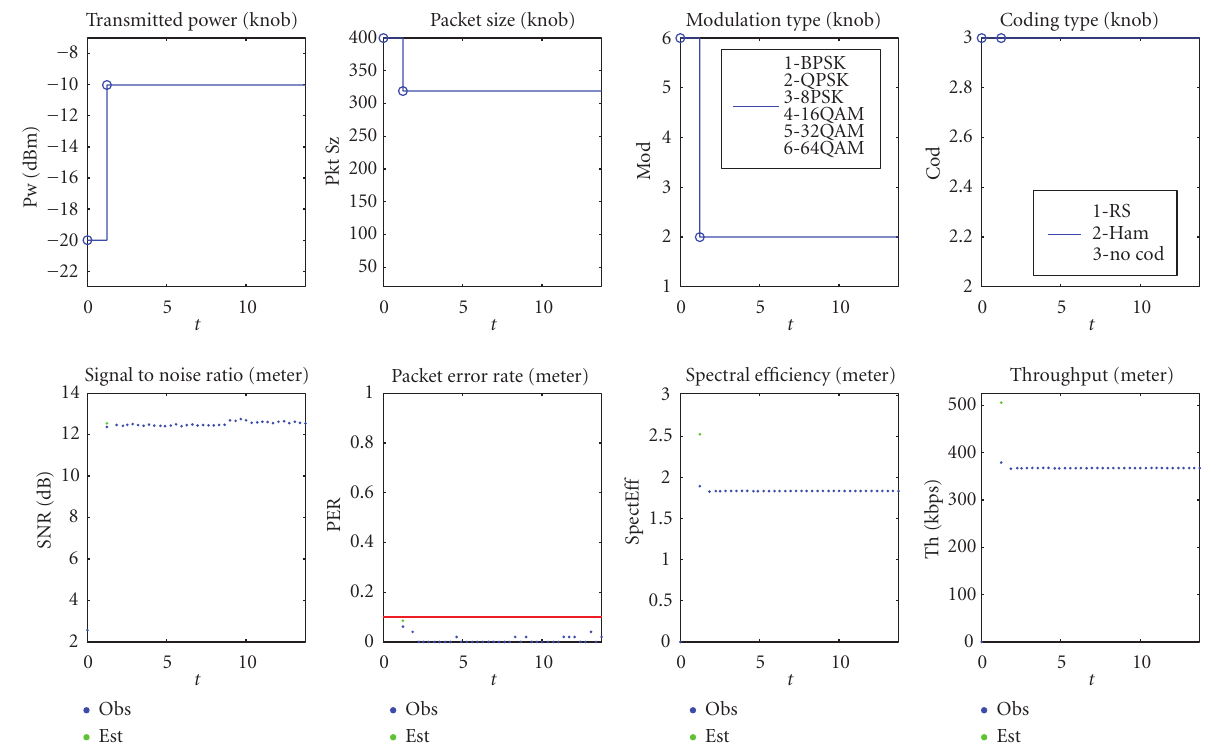
Figure 6: CE with narrow-band interference—in the presence of the narrow-band interference, the engine again raise transmit power and changed modulation to a more robust method. Packet size was able to remain higher than in the wide-band environment. Additionally, error coding was not required. This enabled a higher overall throughput to be